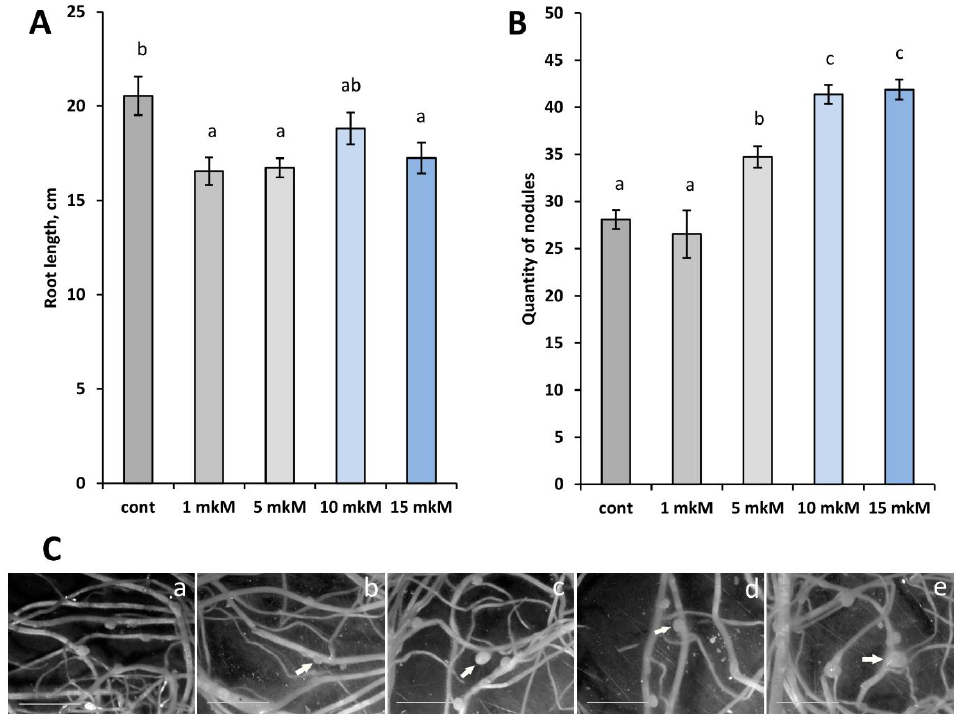
Figure 1. The root length ( A ) and number of nodules ( B ) in sym33-3 mutant plants non-treated (control, a ) or treated with increasing concentrations of cytokinin 6- BAP: 1 μM ( b ), 5 μM ( c ), 10 μM ( d ), and 15 μM ( e ). The graphs show the average values of three independent experiments. The error bars represent standard errors of the mean (SEM) of three repeats. The different letters indicate statistically significant differences based on one-way analysis of variance (one-way ANOVA), followed by Tukey post-hoc test. Nodules are indicated by white arrows. A visual increase in the size of the nodules was noted. Scale bar — 50 mm.